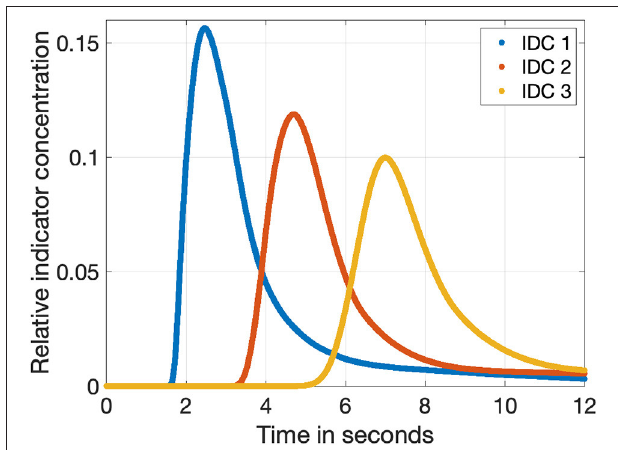
FIGURE 3 | The three indicator dilution curves obtained from the fluid flow model with a sampling rate of 1,200 Hz. The relative concentration is normalized to the input concentration c ICG . The blue, red, and orange curves show the dilution curves in a distance of 50, 100, and 150 cm to the injection side as shown in Figure 2 ,